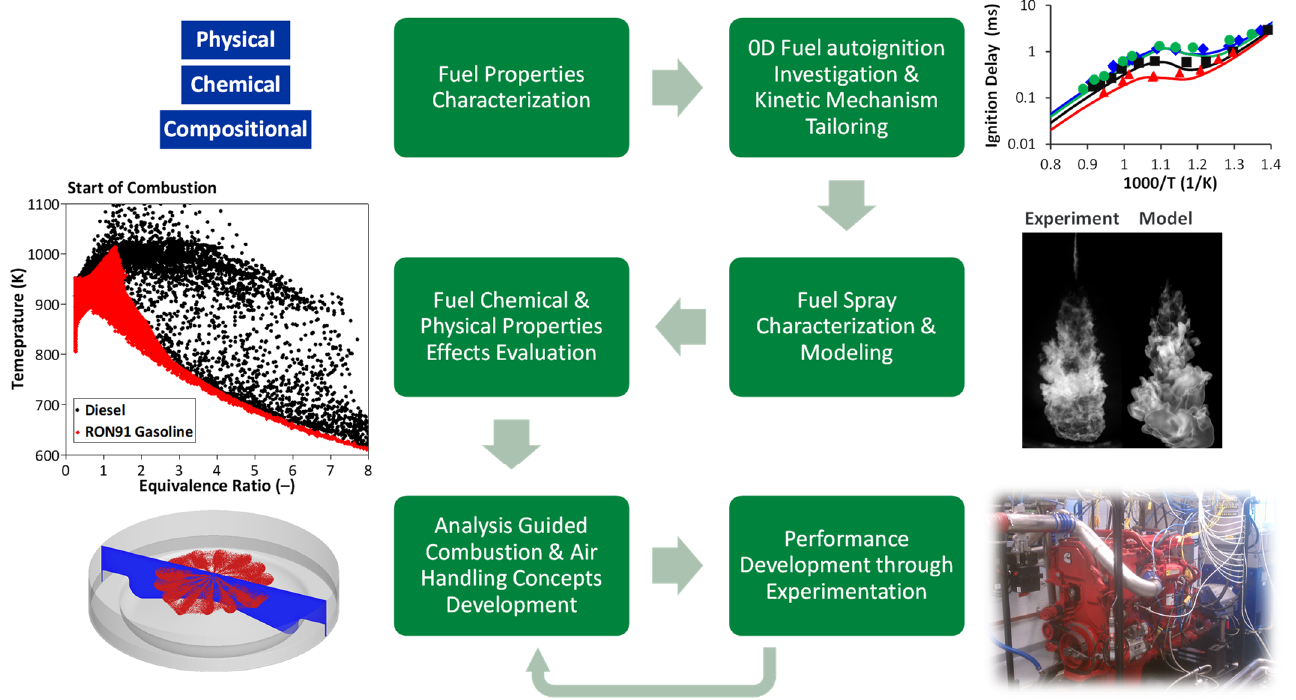
Figure 2. Overview of the analysis-led design approach.